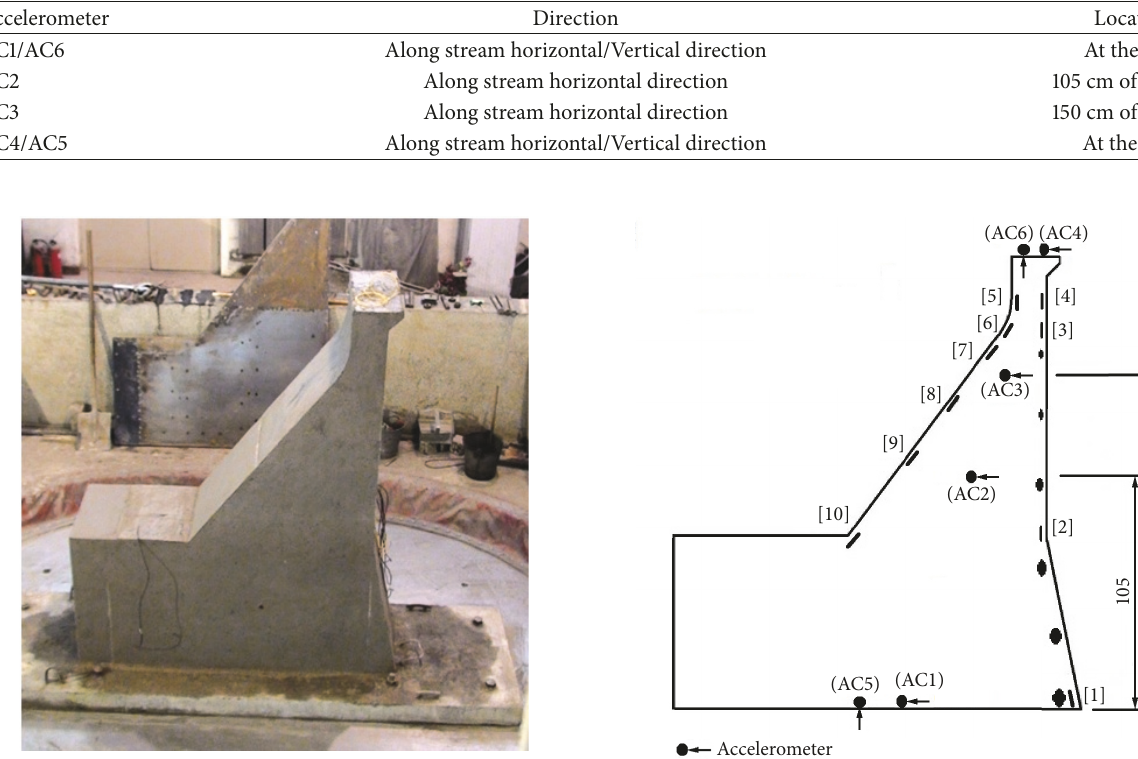
Figure 7: Overview of the model dam.